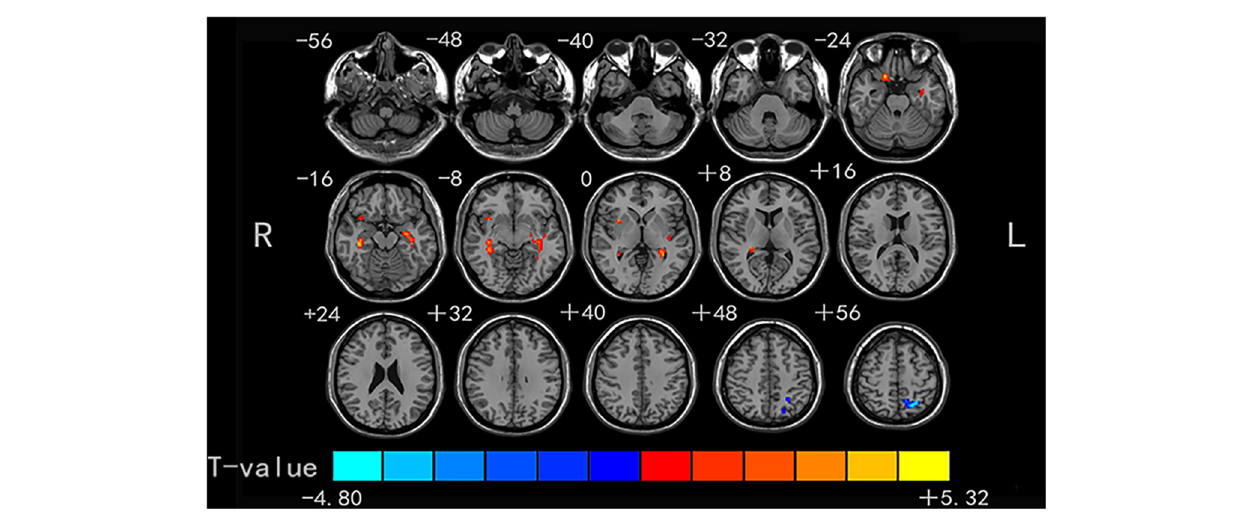
FIGURE 1 | Comparison of DC values between non-NPSLE patients and healthy controls. Warm and cold colors’ areas represent brain regions where DC values of non-NPSLE patients were significantly higher and lower than those of healthy controls, respectively. Cluster-level FDR correction with a voxel threshold of p < 0.001 and cluster threshold of p < 0.05.